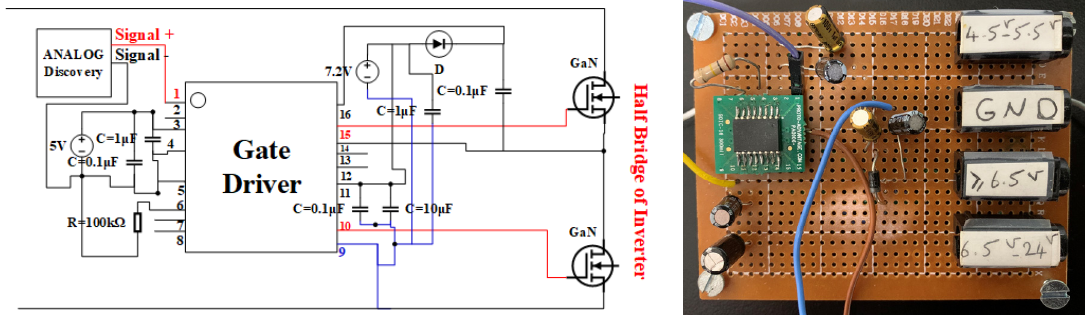
Figure 8. Simulated and experimental design of SI8231AB-D-IS gate driver to control GaN half-bridge inverter.